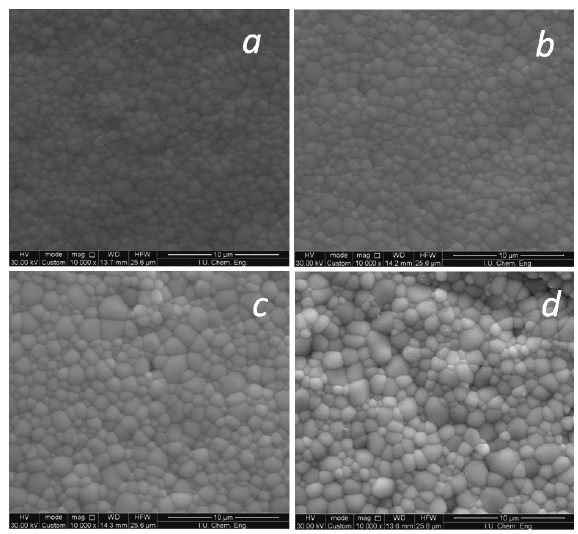
Figure 2: SEM micrographs of the SDC, PSDC6, PSDC9 and PSDC12 samples